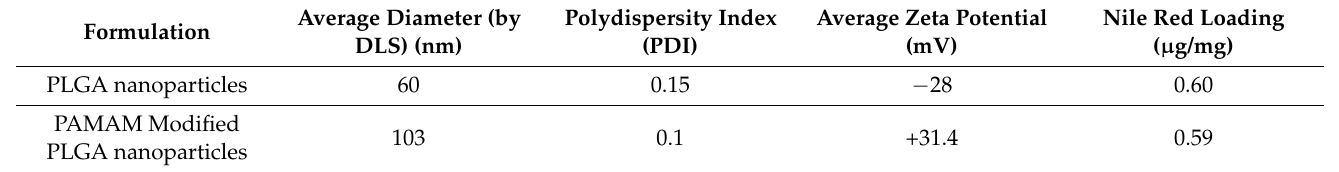
Table 1. Size and surface charge of PLGA and PAMAM-modified